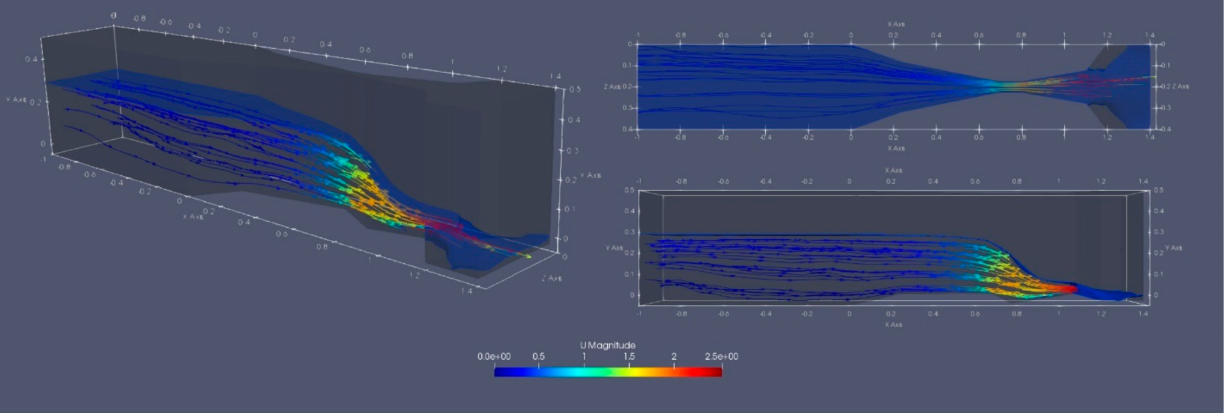
Figure 8. 3D, top, and side views of the Parshall flume.